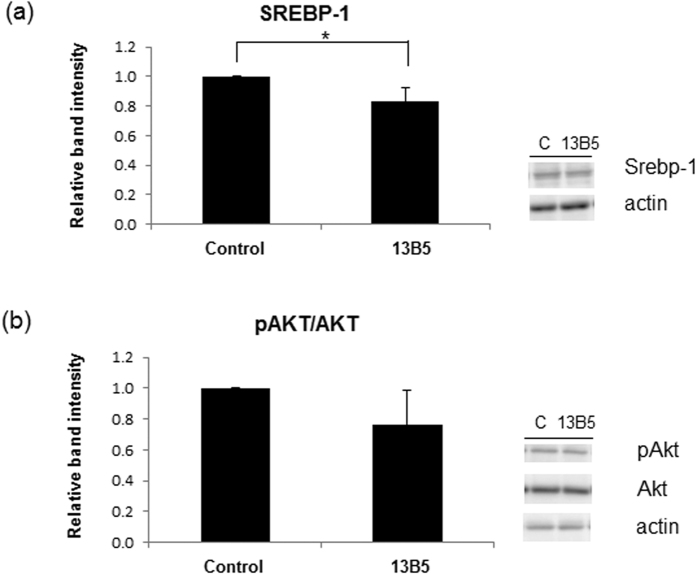
Effects of 13-methylberberine on (a) Srebp-1 and (b) Akt phosphorylation at 24 h. The results are normalized to the control. n = 3 from 3 independent experiments, error bar = standard deviation, *p < 0.05 two-tailed Student’s t-test. 13B5-13-methylberberine 5 µM.